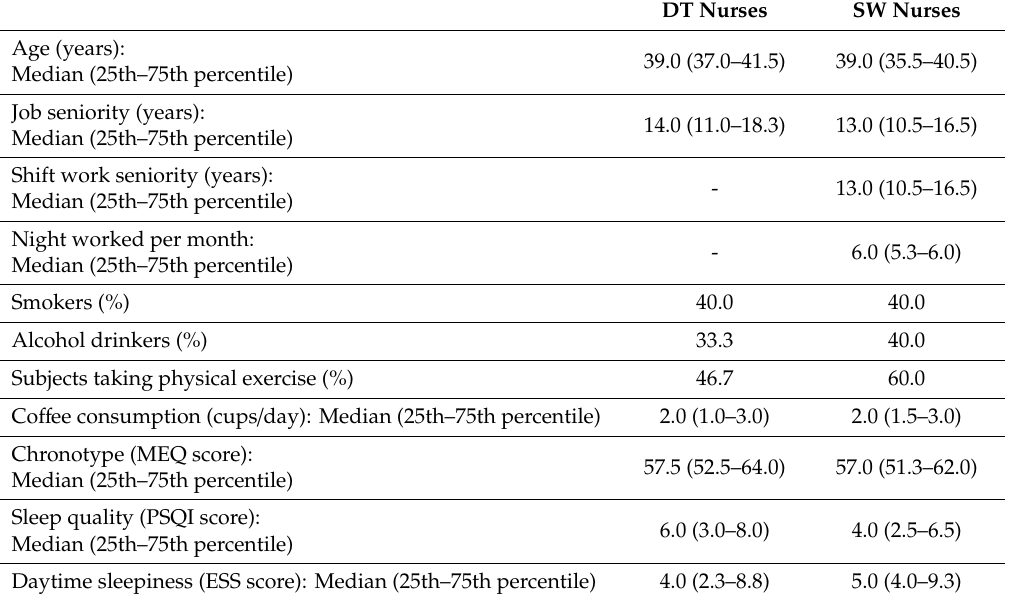
Table 1. Socio-demographic characteristics of daytime (DT) and shift-working (SW) nurses. MEQ: Morningness–Eveningness Questionnaire; PSQI: Pittsburgh Sleep Quality Index; ESS: Epworth Sleepiness